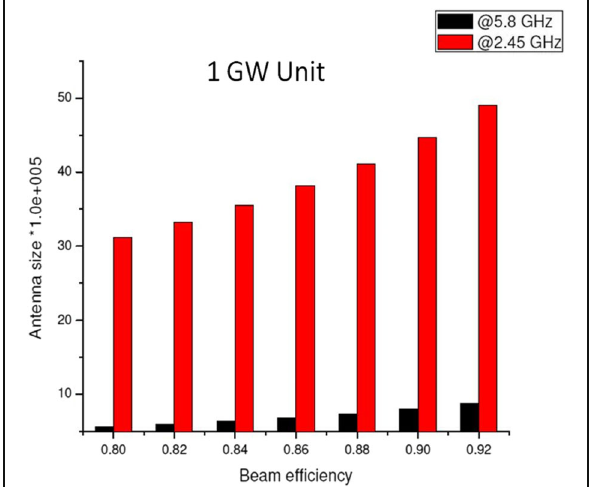
Fig. 9 Antenna size (m 2 ) at 2.45 and 5.8 GHz for 1-GW